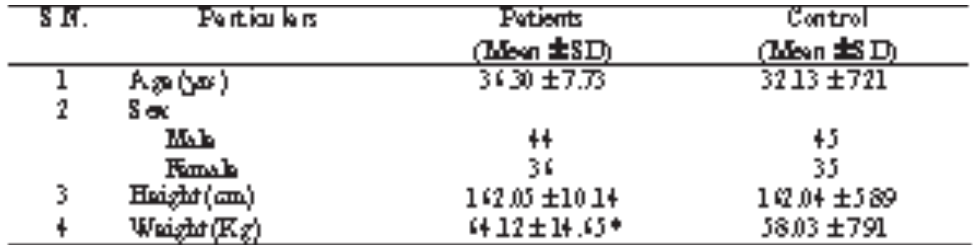
Table I: Profiles of patients &